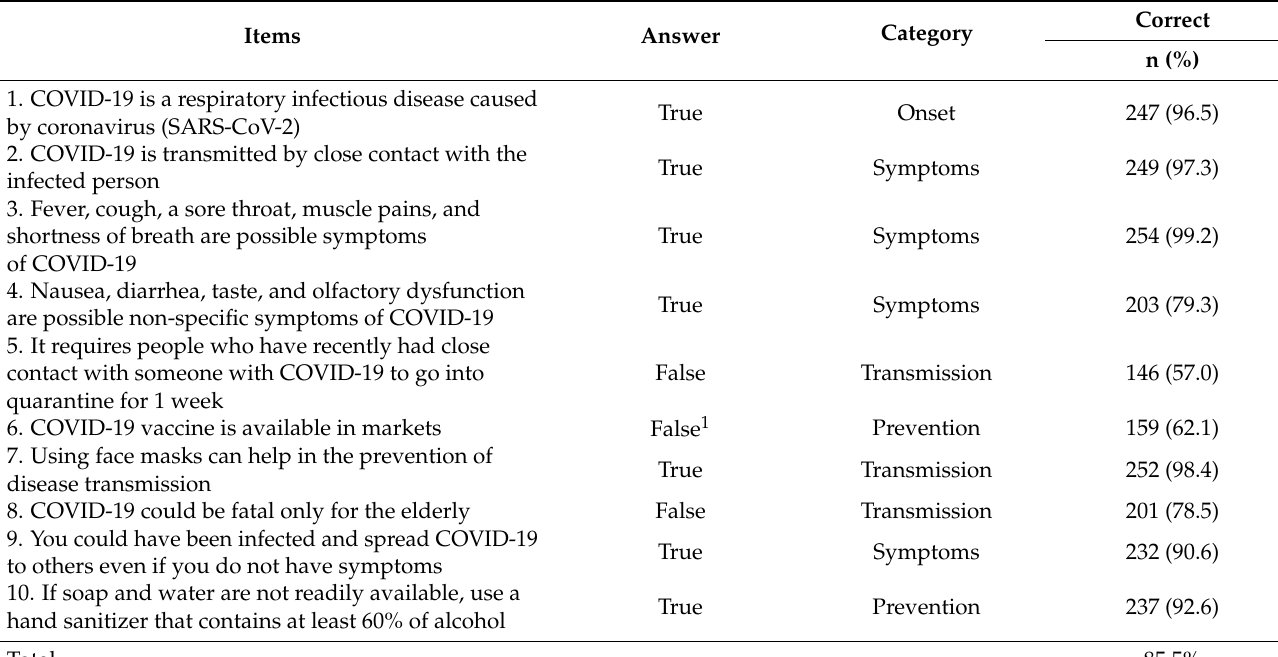
Table 2. Knowledge about COVID-19 ( N = 256).